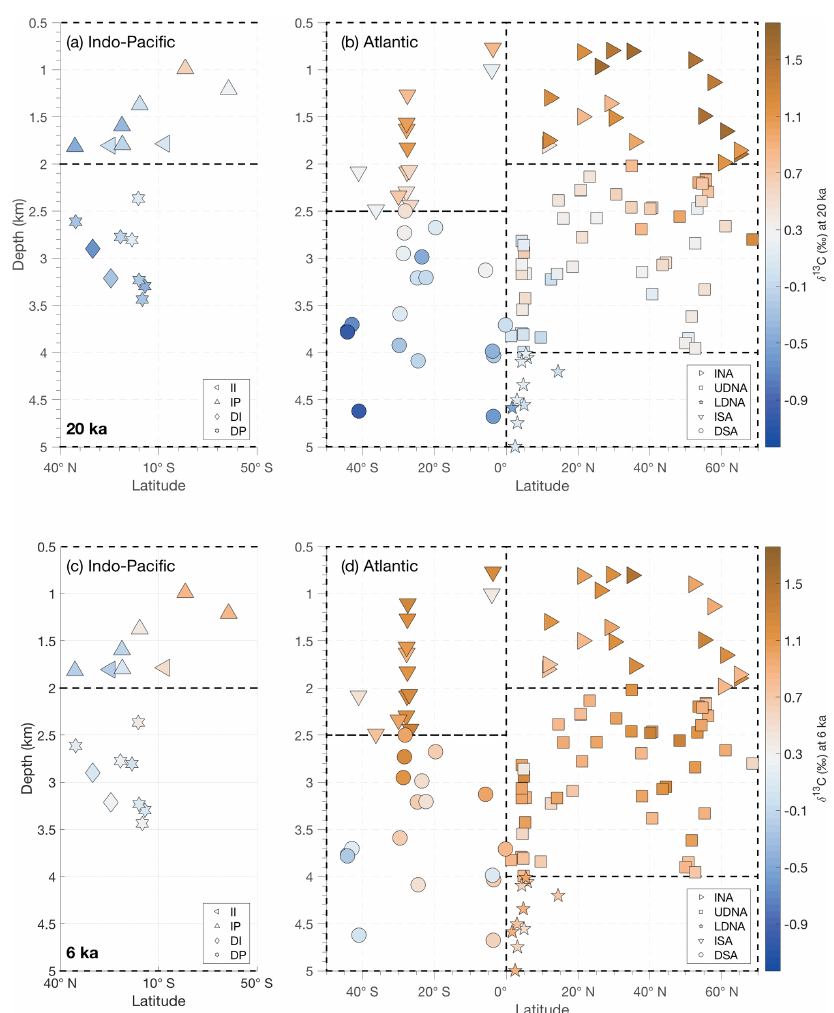
Figure 2. The three-dimensional structure of δ 13 C in the Indian and Pacific oceans (a, c) and Atlantic (b, d) shown as zonally collapsed cross sections (latitude vs. modern water depth) with the same marker scheme as in Fig. 1. Dotted lines indicate region boundaries. Colors show the δ 13 C value at each site for the LGM (20ka, a, b ) and Holocene (6ka, c, d ). Note that latitudes on the x axis are oriented so the Southern Ocean is in the center of the figure. Additional time slices (in 1kyr intervals from 20–6ka) and an animation of deglacial δ 13 C changes can be found in the